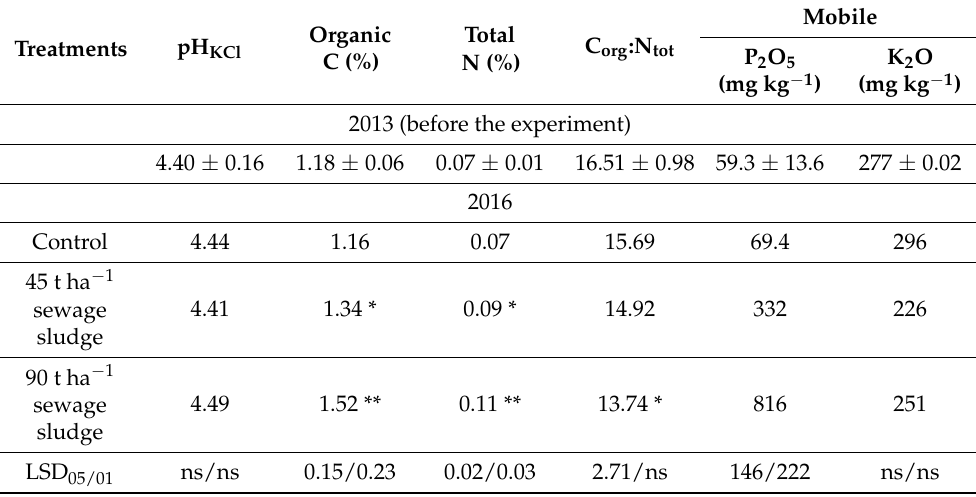
Table 2. Soil chemical content at the growing site of a common osier, specifically for the 0–30 cm upper soil layer (2013 and